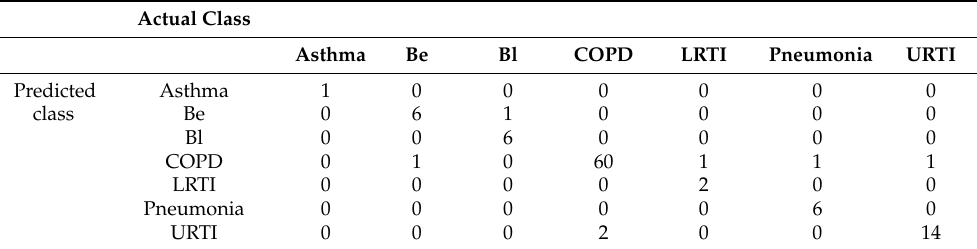
Table 3. Lung disease characterisation confusion matrix. We use the Be and Bl notations to indicate bronchiectasis and bronchiolitis pulmonary disease, respectively.